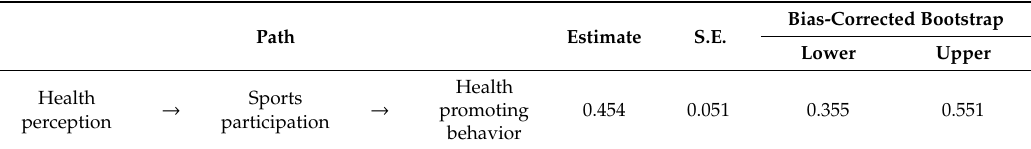
Table 10. Indirect e ff ects